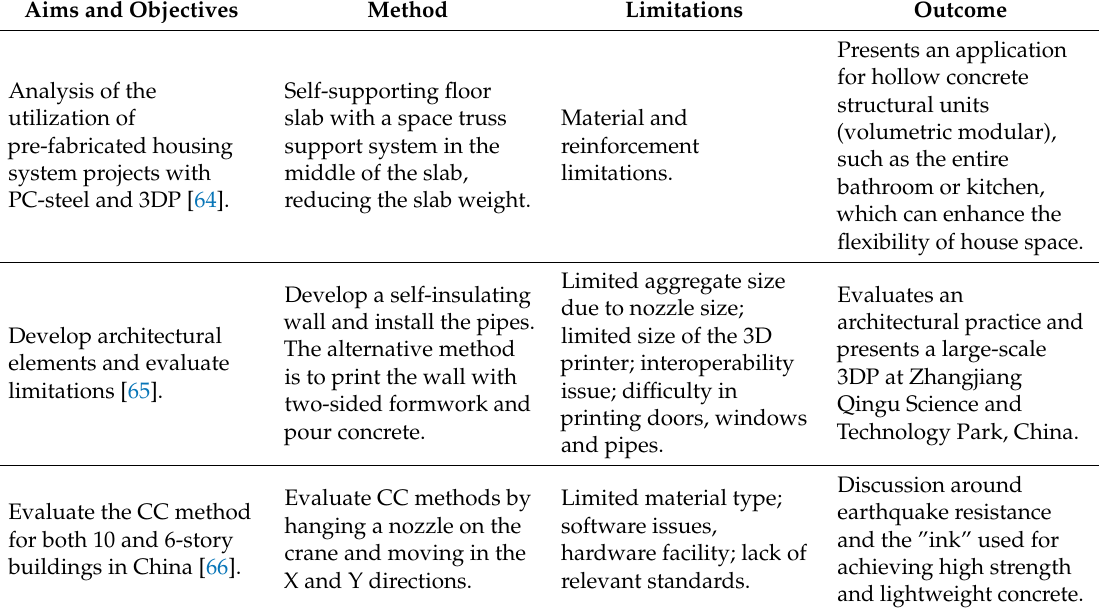
Table 4. Selected papers from the CNKI database related to a detailed analysis of general concepts of 3DP practices, including structural and architectural examples.